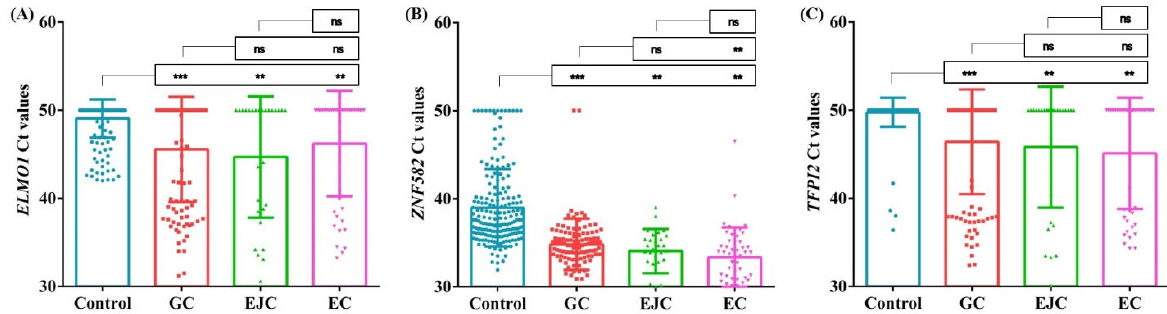
Figure 2. The DNA methylation levels of ELMO1 ( A ), ZNF582 ( B ) and TFPI2 ( C ) in control, GC, EJC and EC plasmas. **, p < 0.01; ***, p < 0.0001, ns, no significant difference according to Student’s t ‐ test.